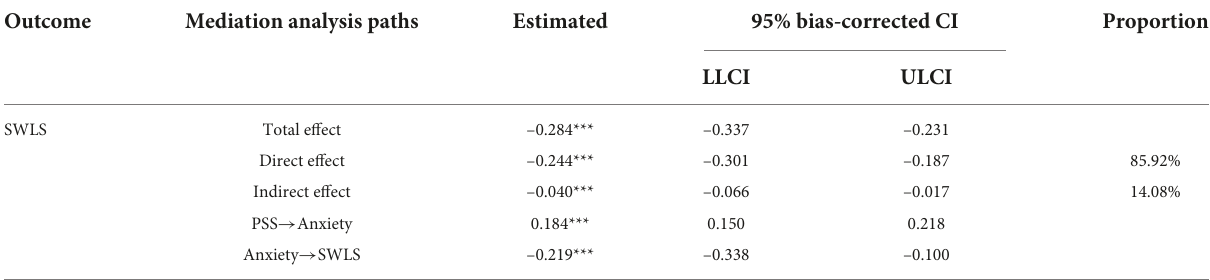
TABLE 3 Mediation effect of anxiety on the relationship between perceived stress and life satisfaction ( n = 654).